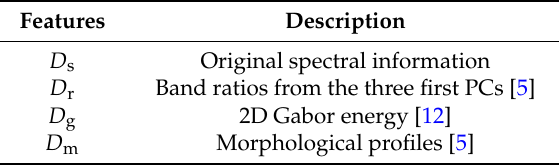
Table 1. Types of features except for spectra via globally filtering in the